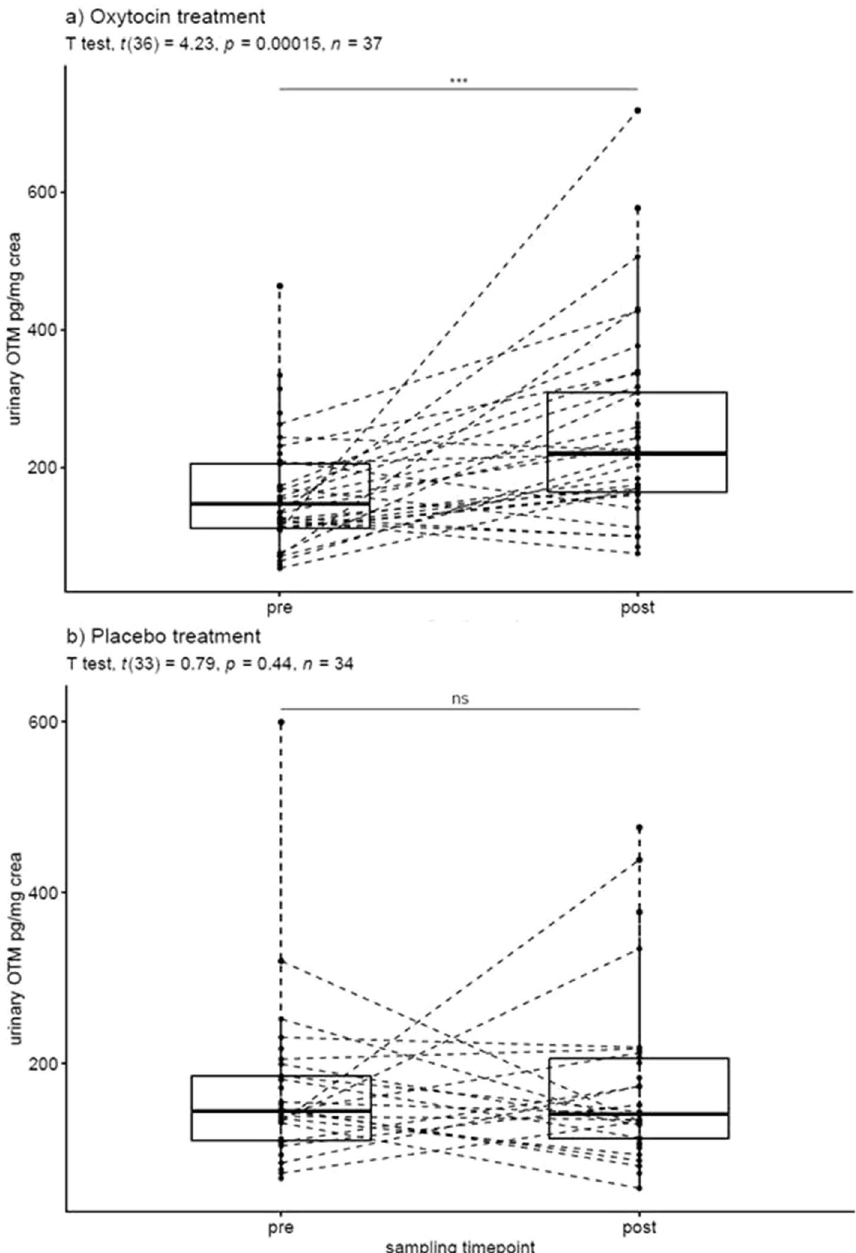
Figure 4. ( a , b ) Individual changes of urinary OTM concentrations following intranasal OT ( a ) or placebo ( b ) treatment in pet dogs (boxes indicate the interquartile range, horizontal lines indicate the